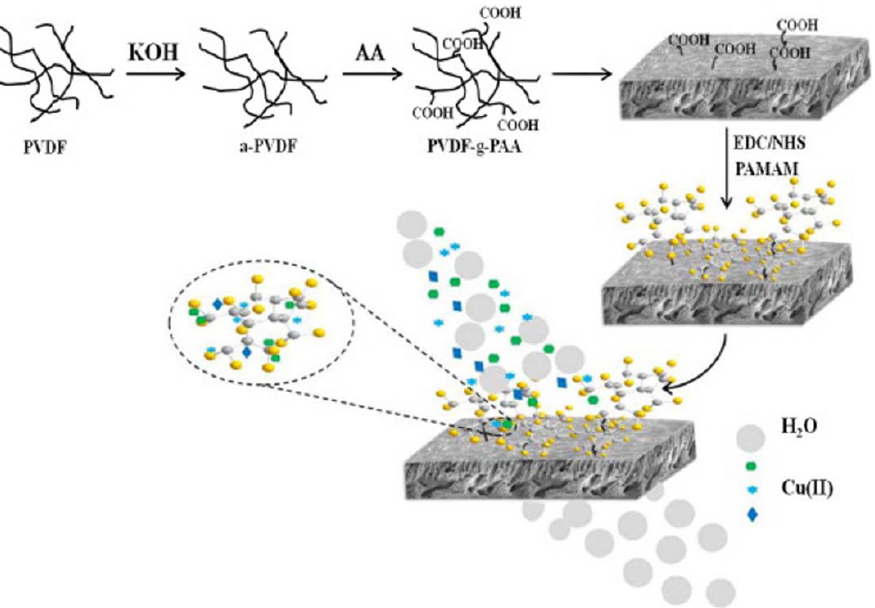
Figure 6. Scheme of preparation of PVDF-g-PAA-PAMAM membrane. Reprinted with permission from Ref. [84]. 2019, Elsevier.